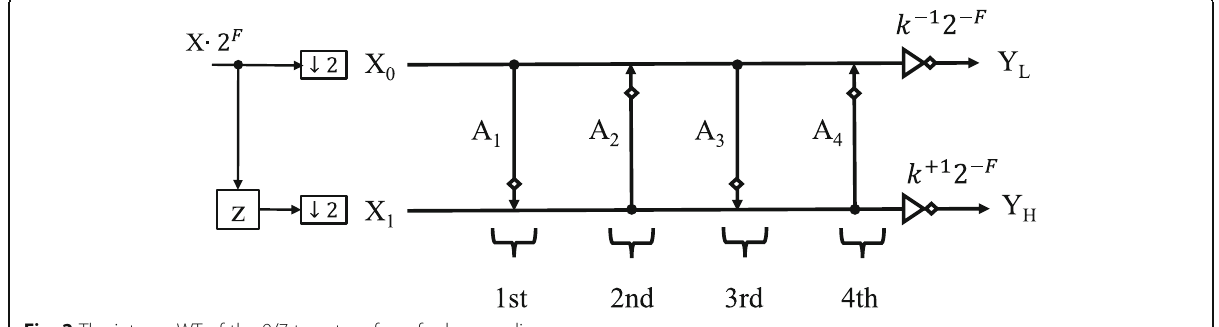
Fig. 2 The integer WT of the 9/7-type transform for lossy